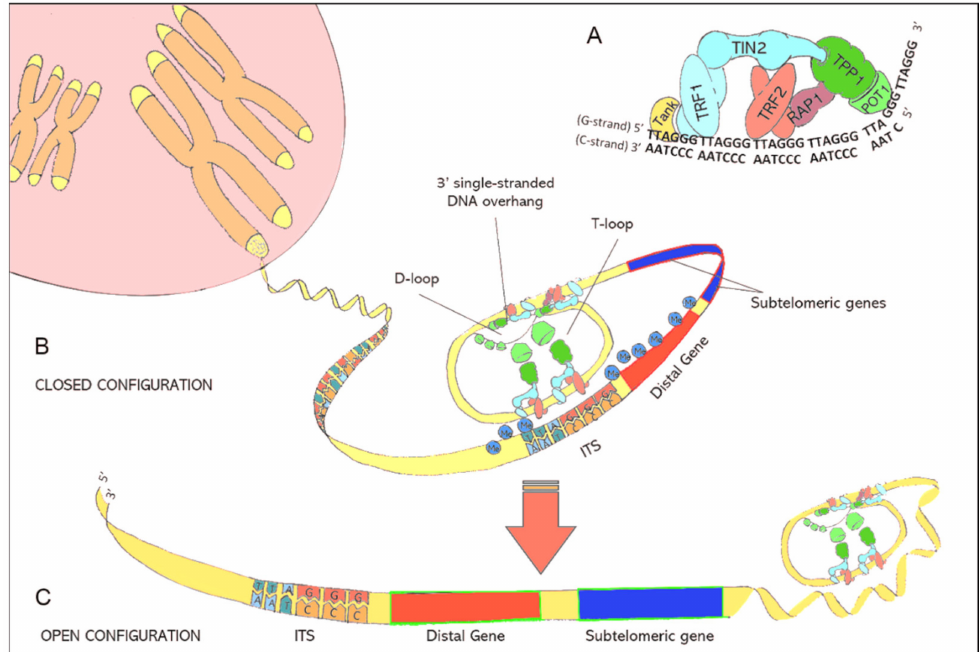
Figure 1. ( A ): Illustration of the shelterin nucleoprotein complex, which protects coding DNA and discriminates telomeres from other free DNA ends resulting from DNA damage. ( B ): Illustration of the closed chromatin configuration at telomeric ends. Due to protein-protein interactions and the specific binding of shelterins to telomeric DNA, double-stranded telomeric DNA is forced to fold back in a loop structure (T-loop) while the 3 (cid:48) single-stranded DNA overhang is hidden inside the D-loop. The binding of shelterins to interstitial telomeric sequences (ITS) leads to the formation of interstitial telomeric loops (ITL) and establishes a closed chromatin structure that impedes the expression of subtelomeric and distal genes through telomere position effects (TPE). ( C ): lllustration of the open chromatin configuration at telomeric ends. Critically short telomeres can no longer maintain the compact chromatin structure. The resulting open chromatin structure facilitates the access of the translational machinery to genes that were formerly silenced by